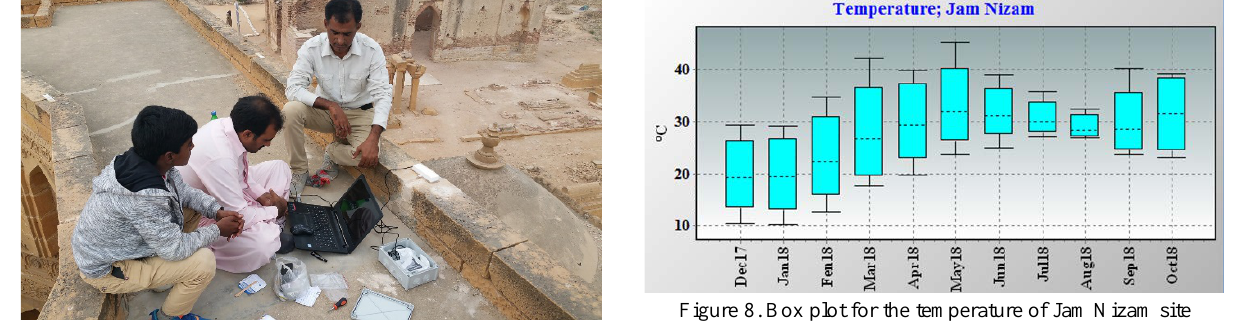
Figure 6. The team installing the digital crack monitor, 2019